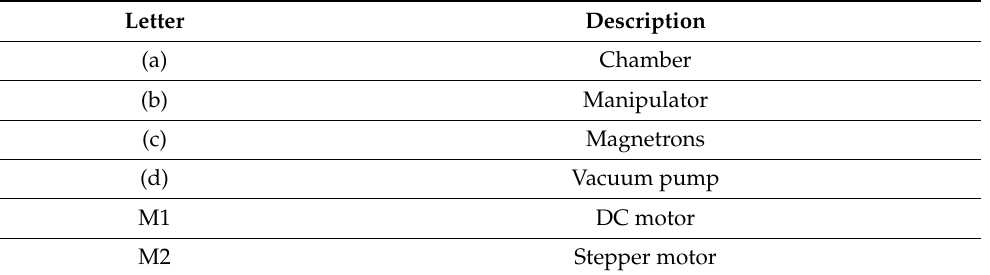
Table 1. Description of the elements listed.